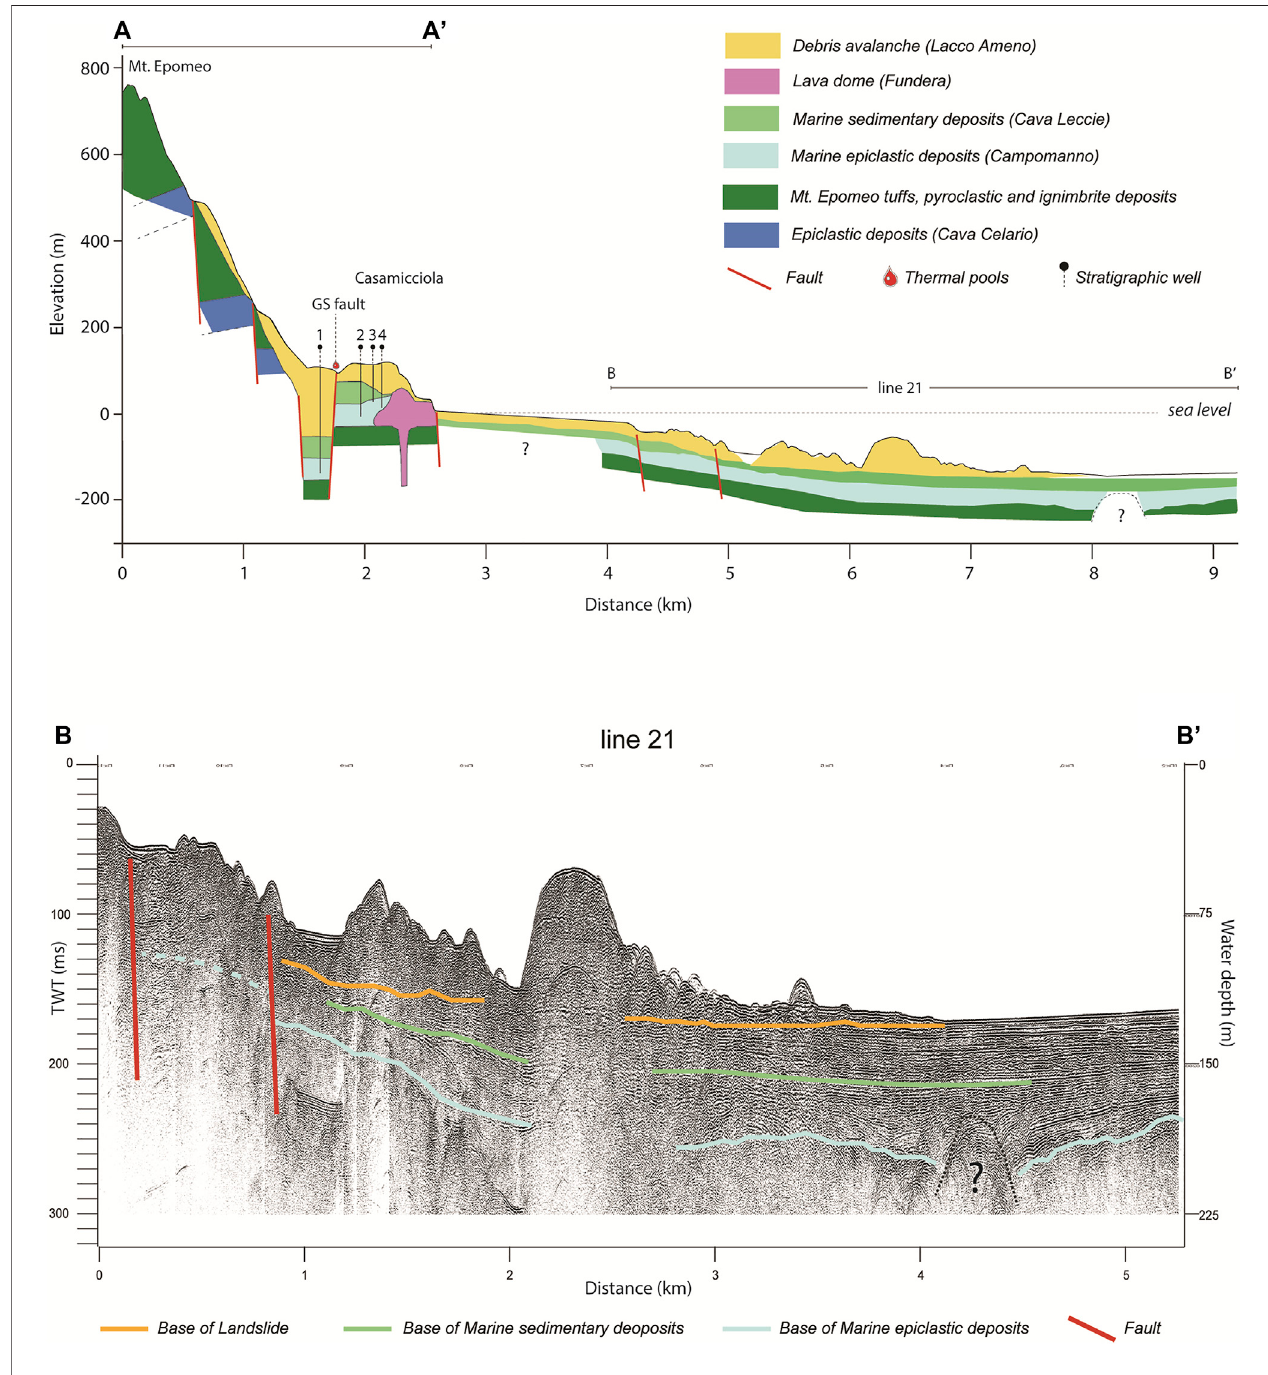
FIGURE 4 | (A) Volcanological sketch of the north side of Ischia Island (onland A – A ’ and offshore B – B ’ sections). one to four indicate the location of the wells illustrated in Figure 3 . The offshore setting is based on the interpretation of the seismic line 21 (B-B ’ ) (B) .